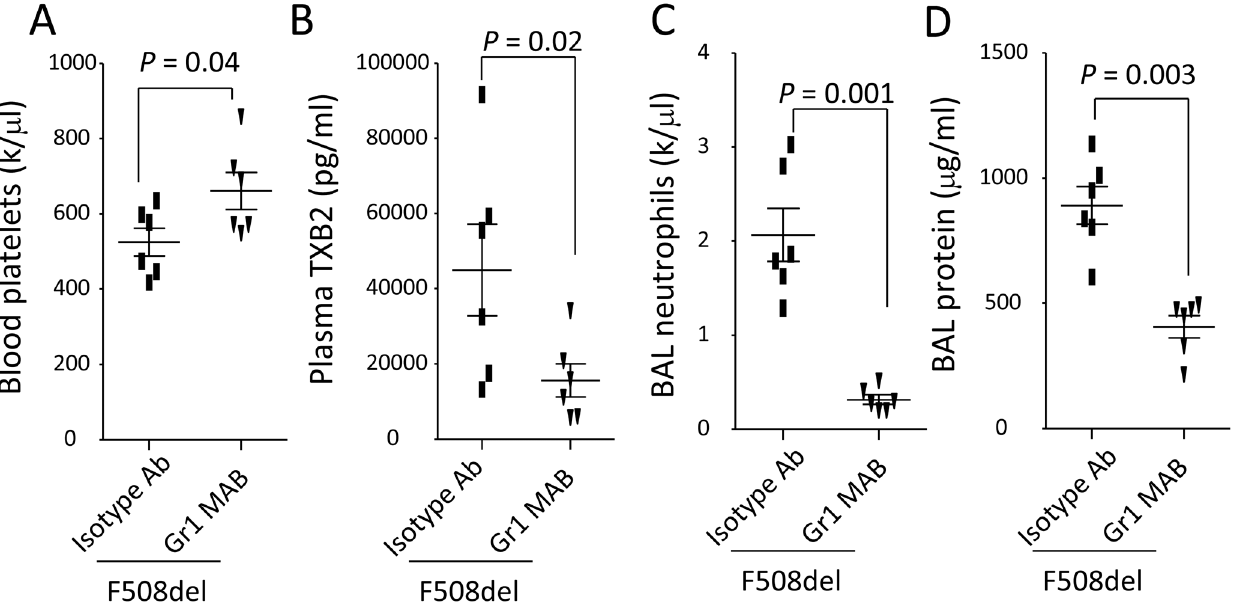
Figure 4. Depletion of neutrophils reverses thrombocytopenia and LPS-induced lung inflammation in F508del mice. A–B . Under intratracheal LPS challenge, depletion of neutrophils in F508del mice reversed thrombocytopenia ( A ) and reduced plasma TXB2 levels ( B ) compared to without neutrophil depletion. C–D . Depletion of neutrophils in F508del mice decreased BAL neutrophils ( C ) and protein levels ( D ) compared to without neutrophil depletion. N=6 in each group. Data were analyzed by t-test and presented in mean 6 SD. P values are listed on each panel.